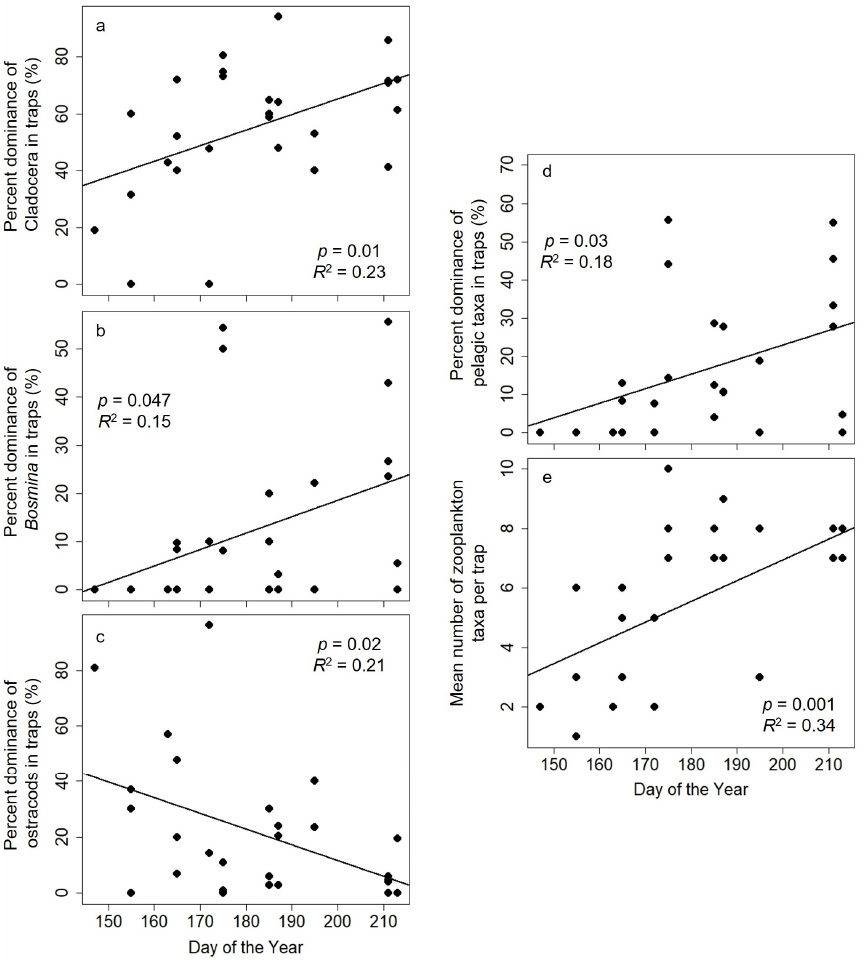
Figure 4. Relations between the percent density dominance in traps of ( a ) Cladocera, ( b ) Bosmina , ( c ) ostracods, ( d ) pelagic taxa, and ( e ) mean number of zooplankton taxa and the day of the year. With the increase in Bosmina and Daphnia (positive but not significant relationship) 3.2. Analysis 2: Trap and Water Column Relations of Zooplankton with Julian day seasonally, the PDD of pelagic zooplankton taxa found in traps significantly increased with Julian day ( p = 0.03; R 2 = 0.18; Figure 4d). Similarly, the mean number of zooplankton taxa found in traps had a positive significant relation with Julian day ( p = 0.001; R 2 = 0.34; Figure 4e; Table 1). PDD by Cladocera and ostracods in traps versus PDD in the water column was significantly different (independent t -test: t ≥ 2.61; p ≤ 0.01; Figure 5). Cladoceran taxa were more dominant in the water column versus in traps: cladoceran PDD was 76 ± 35% in the water column versus 55 ± 23% in the traps. Ostracods were more dominant in the traps, with 22 ± 25% versus 0% in the tows. Copepods and mites were not significantly different in traps versus tows ( p ≥ 0.83). Bladderworts selected for the more littoral taxa of Camptocercus , Chydorus , Eurycercus , mites, Ophryoxus , ostracods, and Pleuroxus (lower bound of the 95% CI ≥ 0.11, greater than 0.1). Bladderworts also selected for copepods (1.6 ± 0.5), which did contain littoral harpacticoids. Bladderwort selectivity for the pelagic Bosmina (0.1 ± 0.4) and Daphnia (0.5 ± 0.7) was